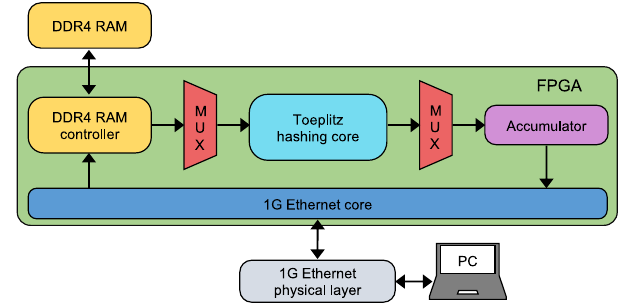
Fig. 5 | Schematic of the post-processing on the ZCU111 evaluation board. The raw numbers are stored on a personal computer (PC) and sent to the fi eld pro- grammable gatearray(FPGA)via1GEthernet.Thedataisstoredinthedouble data rate4thgenerationrandomaccessmemory(DDR4RAM)ontheprocessingsystem (PS) and multiplexed into the Toeplitz hashing core on the programmable logic (PL) side of the FPGA. The output from the Toeplitz hashing core is accumulated and sent back to PC via 1G